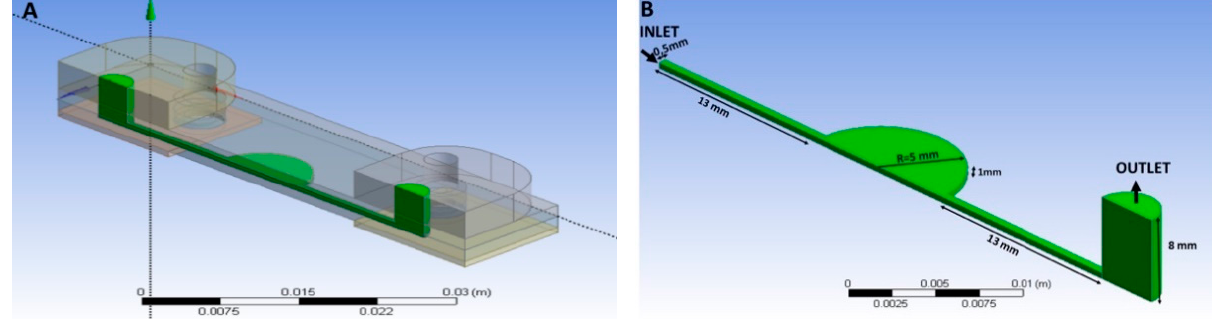
Figure 3. Computational domain: ( A ) 3D view of the computational domain representing half of the microfluidic domain. ( B ) Default domain.